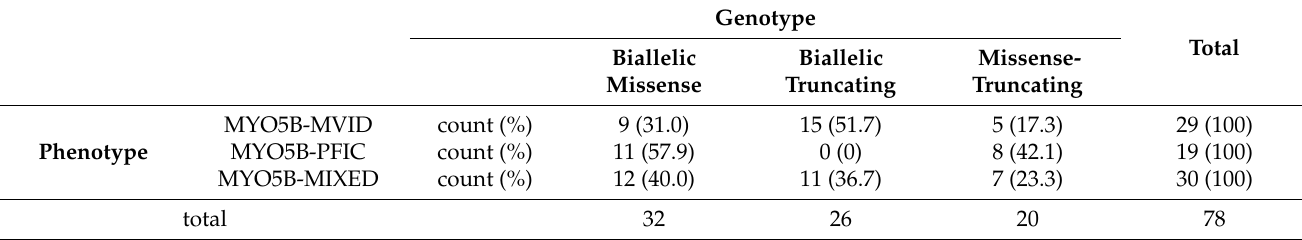
Table 3. Biallelic MYO5B genotypes (n = 78) observed within 3 phenotype